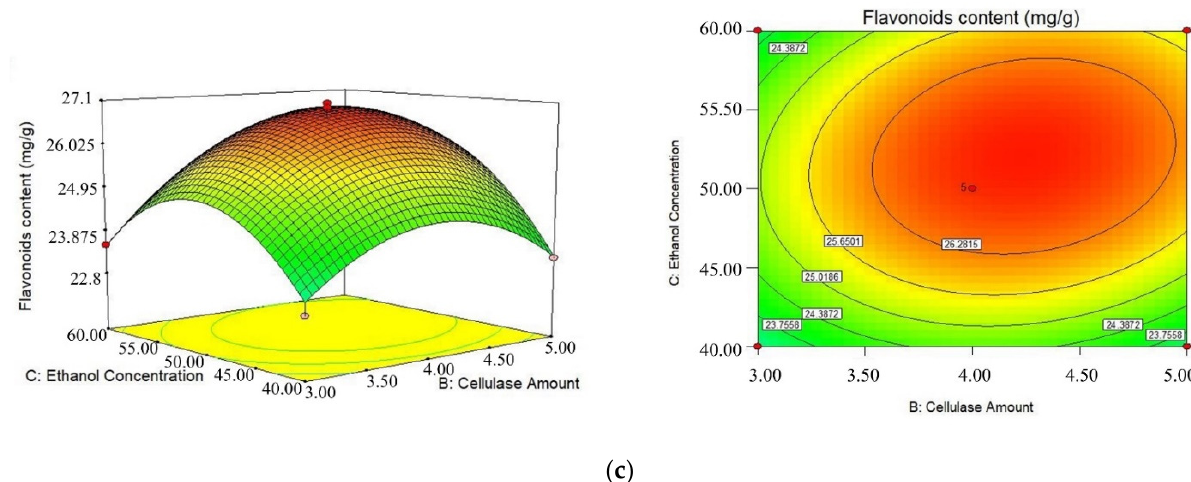
Figure 2. Response surface 3D and contour plots of different factors to effect the flavonoid content of NHE. ( a ) Liquid-to-solid ratio and cellulase amount; ( b ) Liquid-to-solid ratio and ethanol concentration; ( c ) Cellulase amount and ethanol concentration.